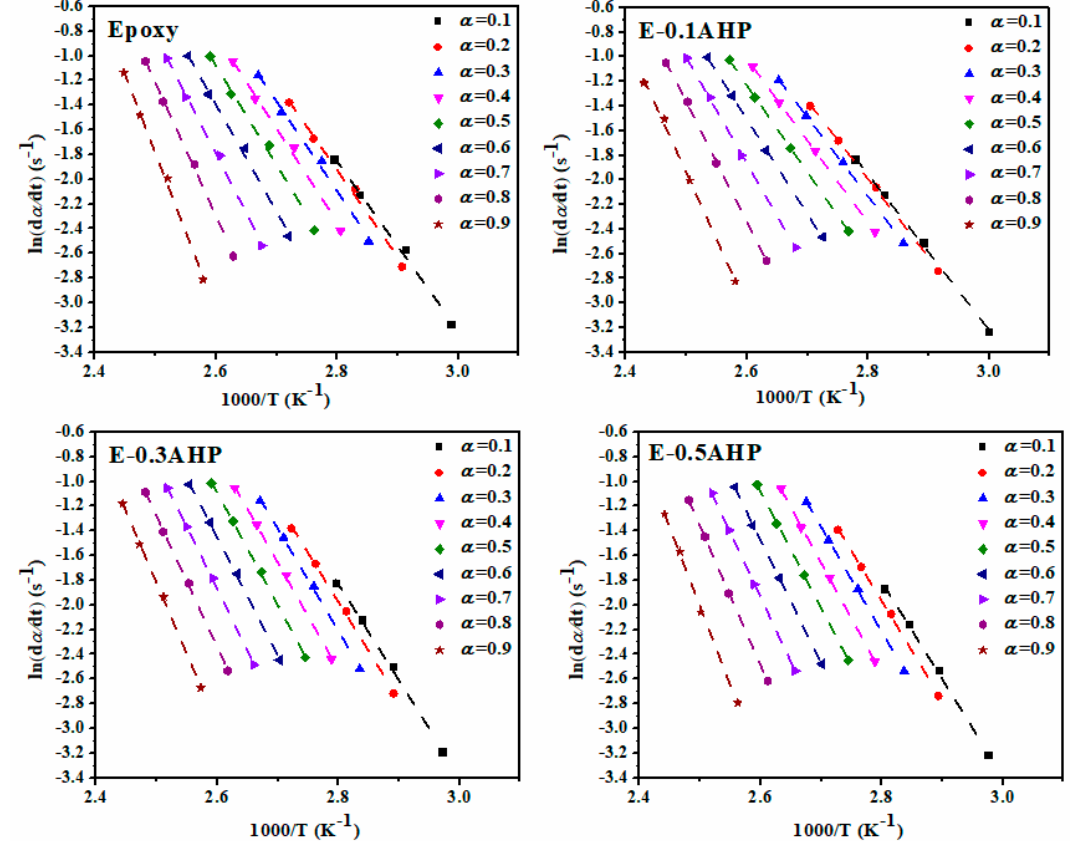
Figure A1. Plots of ln ( d α /dt ) vs. 1/T of the prepared samples based on Friedman model at β = 5 ˚